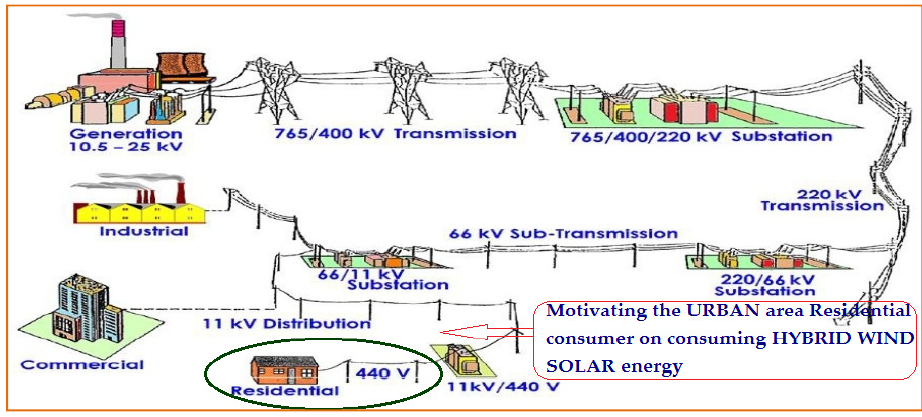
Figure 1. The basic structure of the Indian power system.